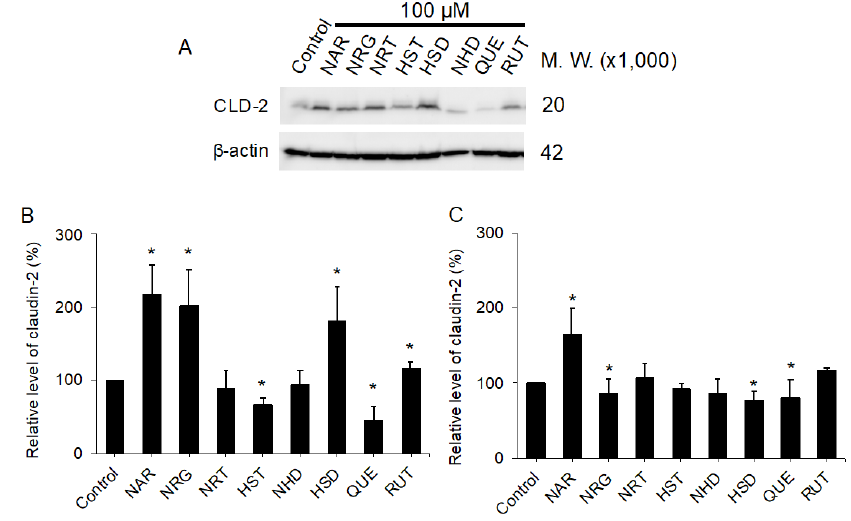
Figure 4. Changes in the relative amounts of protein CLD-2 after 100 or 10 µ M flavonoid treatment for 48 h in MDCK II cells. ( A ) Western blotting analysis of CLD-2 expression in cell lysates from control and 100 µ M flavonoid-treated MDCK II cells. ( B , C ) Quantitative analysis with densitometry of 100 µ M ( B ) and 10 µ M ( C ) flavonoid-treated MDCK II cells. Error bars indicate standard deviations. Statistical analyses were performed via Tukey–Kramer multiple comparison tests. Di ff erent from the value of the control cells, * p < 0.05. NAR: n = 16; HST, HSD, QUE: n = 8; NRG, NRT, NHD: n = 7; RUT: n = 3. In Supplementary Figure S5, we show the raw materials used for ( B , C ). MDCK: